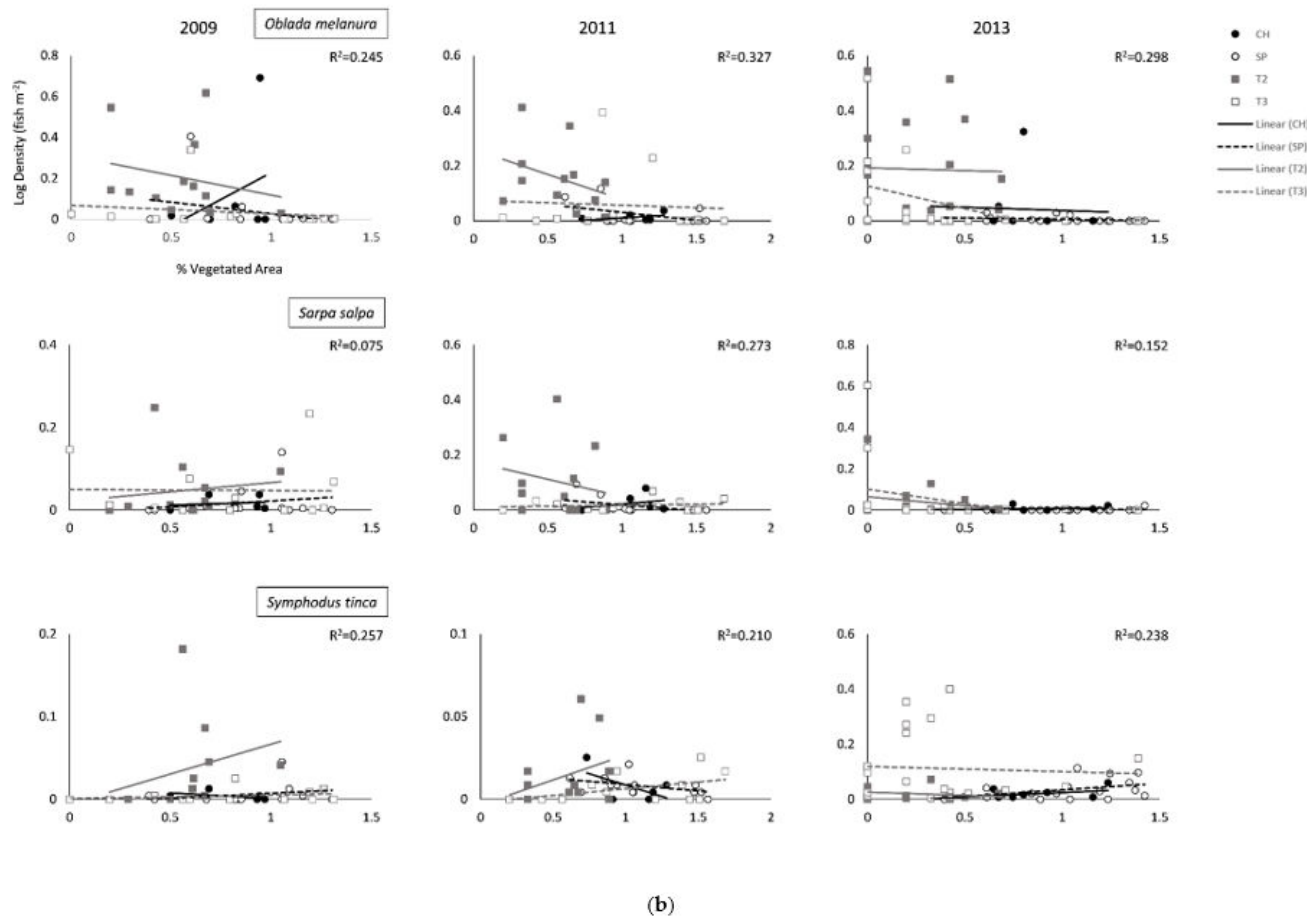
Figure 3. ( a ). Relationships (Global R 2 ) between Shannon–Wiener habitat diversity index and annual average density for all fishes and the five most abundant species per survey site ( Cabo de las Huertas —CH; Santa Pola —SP; Tabarca II—T2; Tabarca III—T3). Global R 2 values depict overall global fit for each ANCOVA model. ( b ). Relationships (Global R 2 ) between Shannon–Wiener habitat diversity index and annual average density for all fishes and the five most abundant species per survey site ( Cabo de las Huertas —CH; Santa Pola —SP; Tabarca II—T2; Tabarca III—T3). Global R 2 values depict overall global fit for each ANCOVA